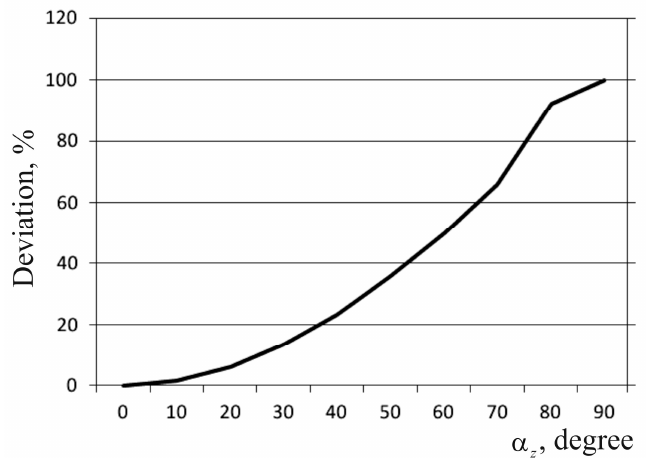
Figure 11. Graph of the dependency of the SE α z measurement axis deviation on the deviation from